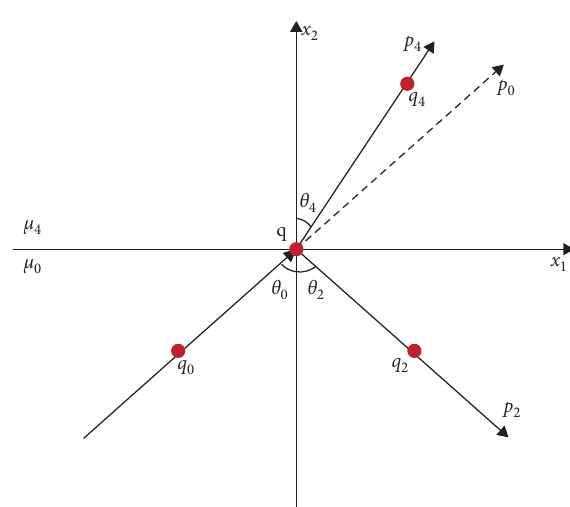
Figure 5: Refraction diagram of the SH